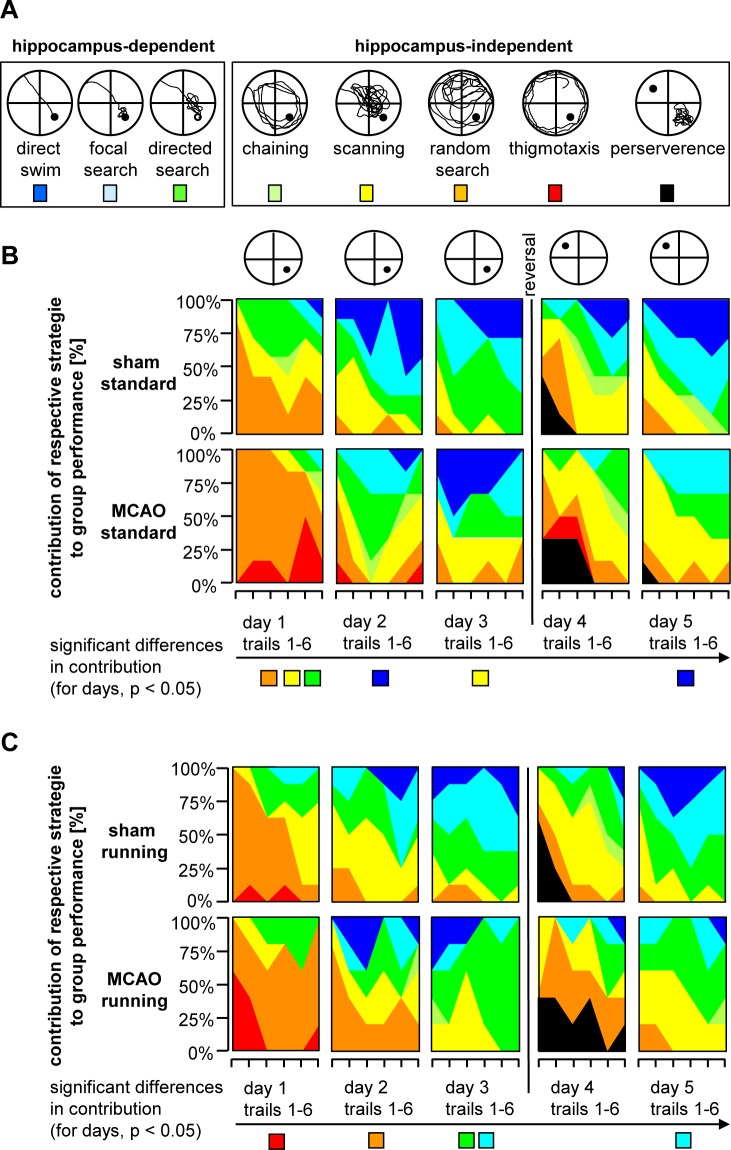
Stroke animals employ less hippocampus-dependent search strategies.A, Schematic illustration of distinct hippocampus-dependent and -independent search strategies in MWM. B/C, Contribution of single search strategies to group performance in MCAO- and sham operated animals either following standard housing (B) or free access to running wheels (C). Color code as indicated in A.